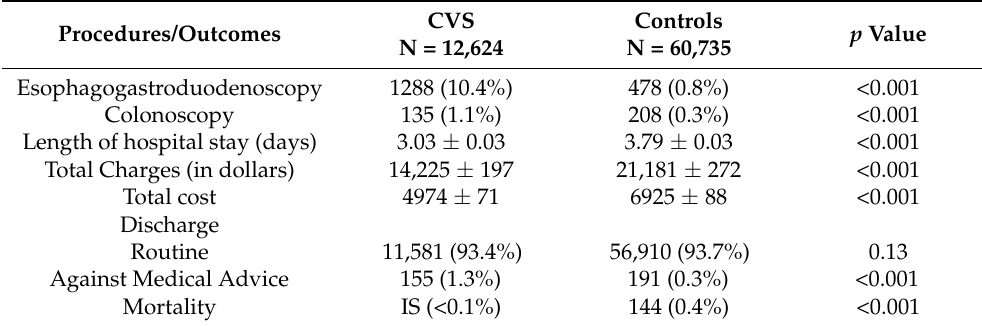
Table 2. Comparison of Gastrointestinal procedures and hospital outcomes between the groups. Procedures/Outcomes